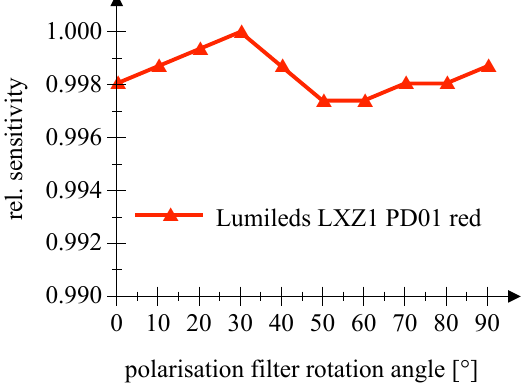
Figure 16. This figure shows the measured sensitivity as a function of the polarization angle for a red Lumileds LED employed as